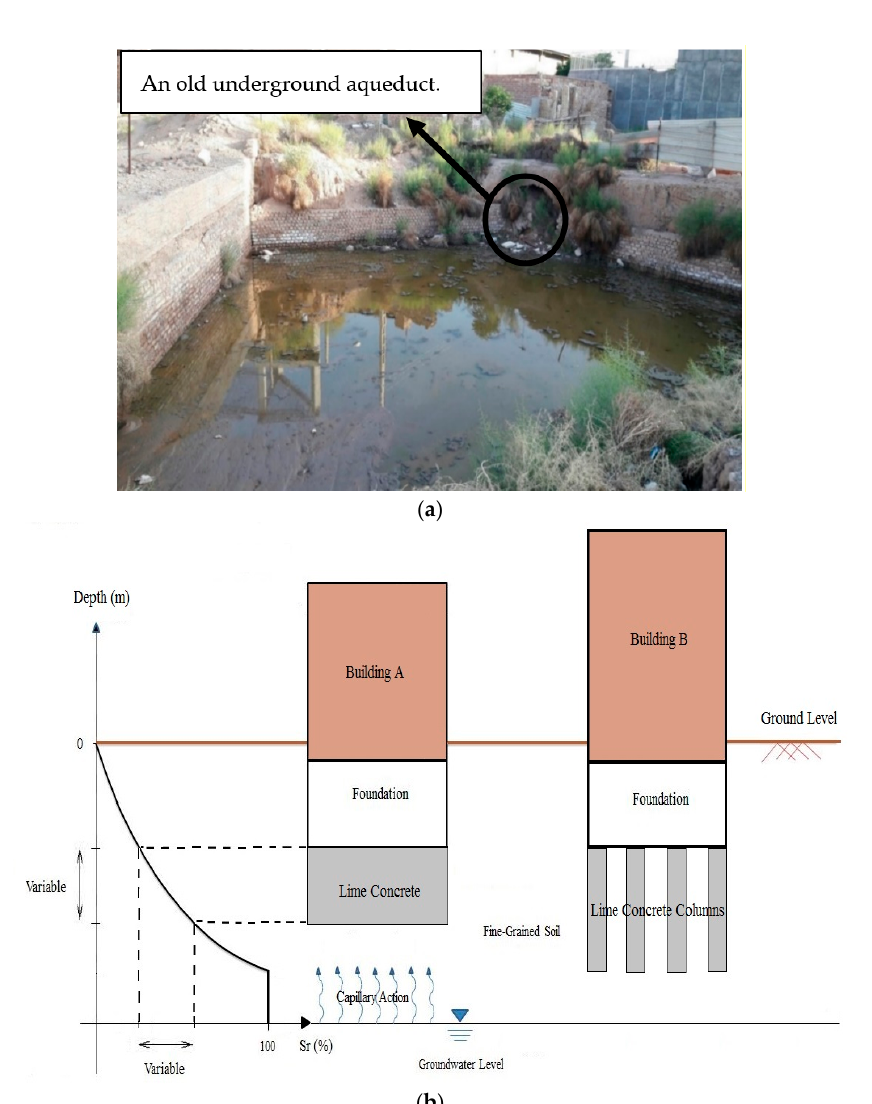
Figure 1. Water penetration into lime-based concrete; ( a ) a dug land exposed to the rise in ground- water level and aqueducts in Kerman city; and ( b ) The effect of the capillary phenomenon on two buildings constructed over LCC and LCC columns [23].